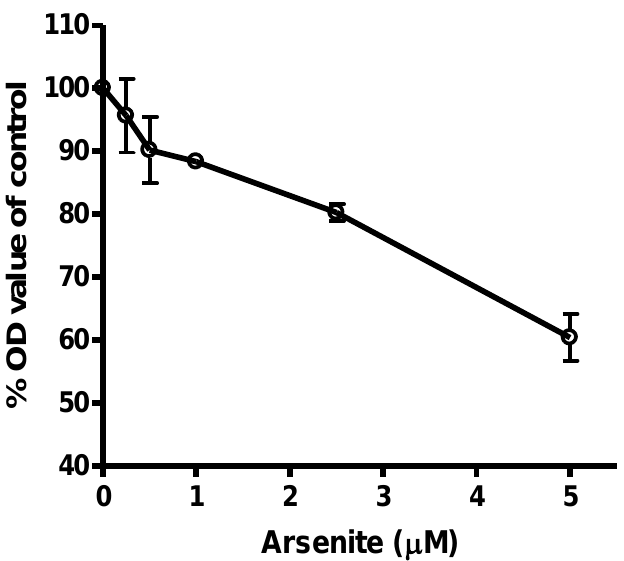
Figure 2. Correlation plot of mean ∆Ct values from repeated TLDA experiments. Panels A and B show representative  Ct values obtained from repeated experiment with two different samples. The ΔCt (The Ct values normalized to loading control) for experiment 1 was plotted against the ΔCt for repeated TILDA runs. Linear regression analysis was used to determined Pearson correlation coefficient (r) and p